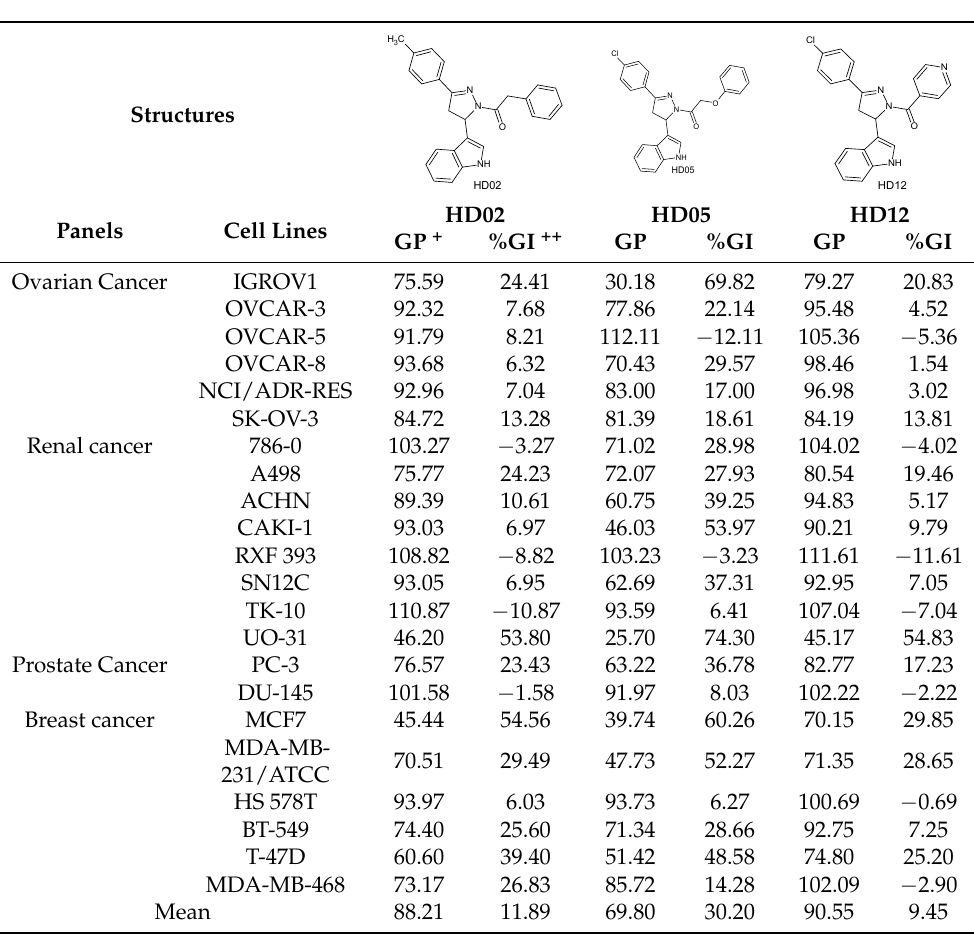
Table 2. Anti-cancer activity of compounds, HD02, HD05, and HD12 against 56 NCI cancer cell lines. Table 2. Cont.